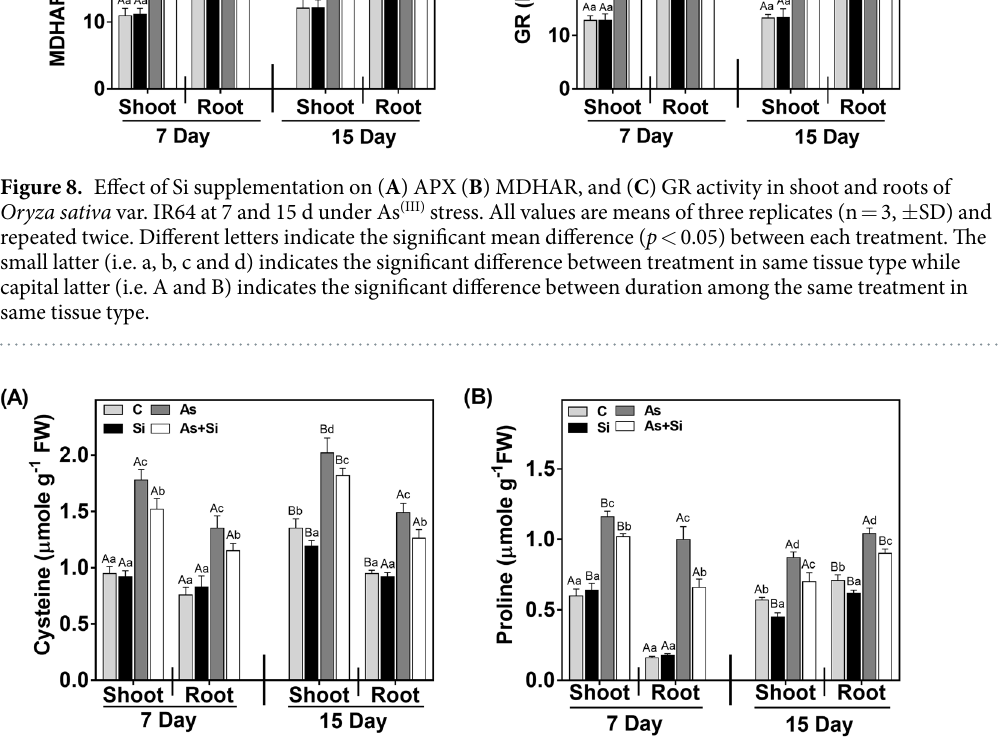
Figure 9. Effect of Si, As (III) , and As (III) + Si on ( A ) cysteine ( B ) proline content in shoot and roots of Oryza sativa var. IR64 at 7 and 15 d. All values are means of three replicates (n = 3, ± SD) and repeated twice. Different letters indicate the significant mean difference ( p < 0.05) between each treatment. The small latter (i.e. a, b, c and d) indicates the significant difference between treatment in same tissue type while capital latter (i.e. A and B) indicates the significant difference between duration among the same treatment in same tissue